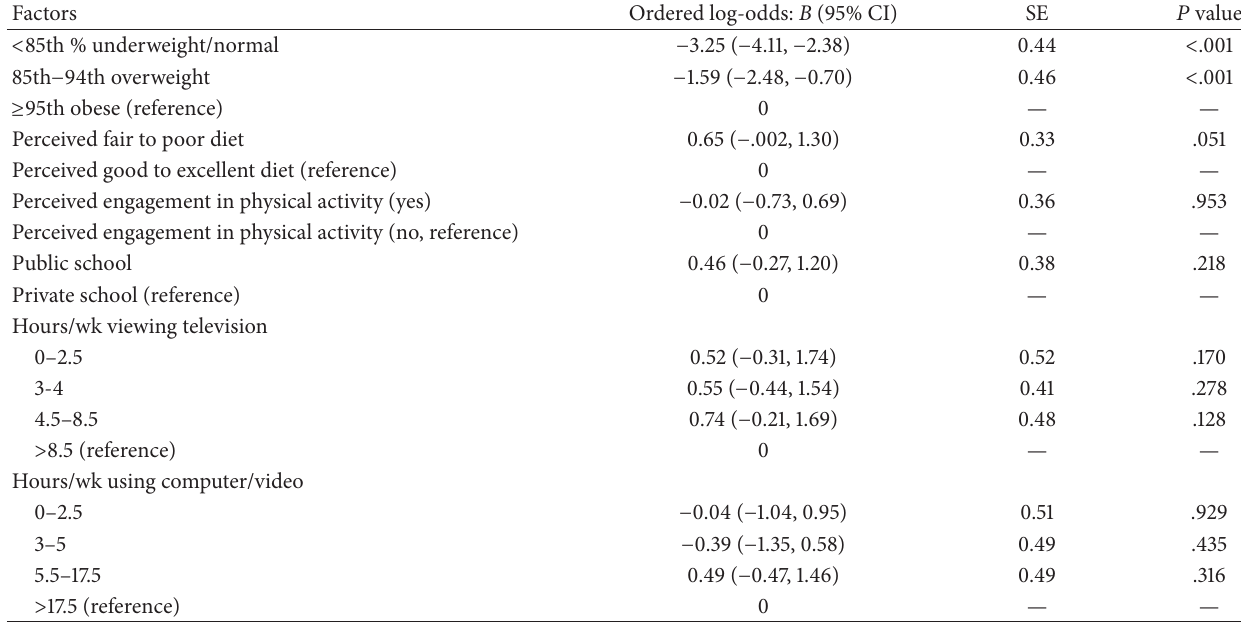
Table 3: Ordinal regression model for body